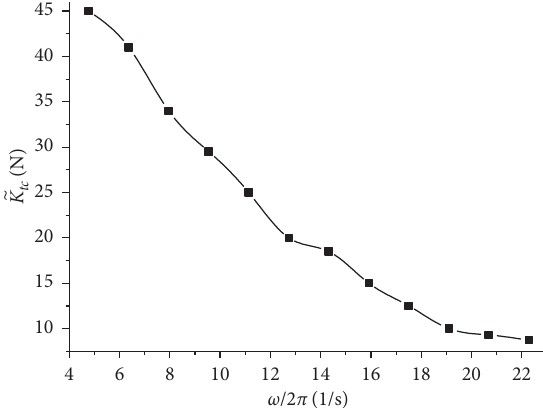
Figure 12: The required control gains for chaotification versus the excitation